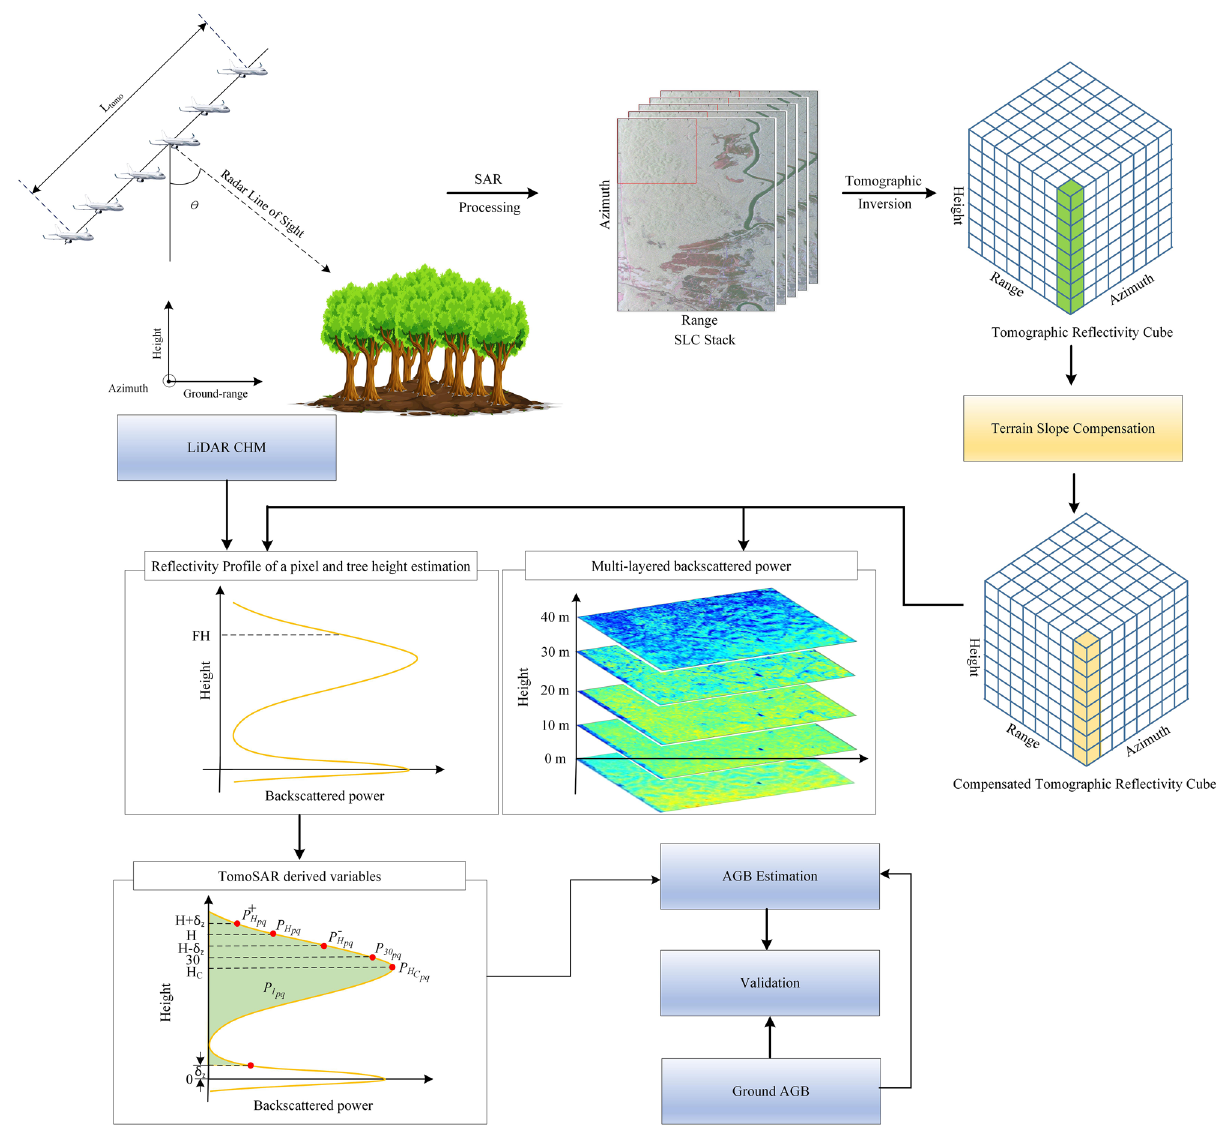
Figure 2. Overview of the methodology followed in this research. This Figure is generated using Inkscape 1.2.2 58 . The images of tree, ground and airplane in figure are used from 59–61 , x , g , z Here, P s m is the slope compensated TomoSAR reflectivity within the azimuth-ground range resolution (cid:31) (cid:30) cell ( x , g ) at height layer z from the ground level using estimator m , θ is the radar incidence angle α denotes the local slope in ground range geometry, and m represents the reconstruction algorithm ( m can be BP or Capon or MUSIC). The FH was estimated from the TomoSAR using the approach adopted by 27 (summarized in Sup- plementary Method S2). Further, in this study, we derive the TomoSAR power metric (Q) based on vertical resolution, retrieved FH, and phase center, as defined below in Eq. (2), to estimate and validate a variable that can substitute for TomoSAR backscatter power at 30 m. To provide simplified notation, P s m from Eq. (1) is written as P pq in Eq. (2), where p , q represents transmitted and received polarization. P = P s m and